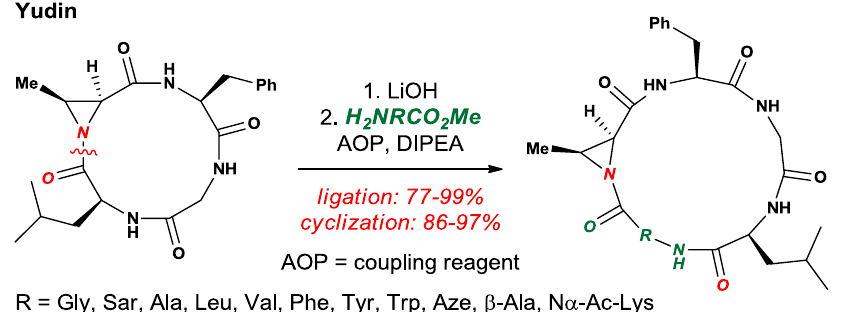
Figure 24. Cyclic Twisted Amide-Containing Tetrapeptides.